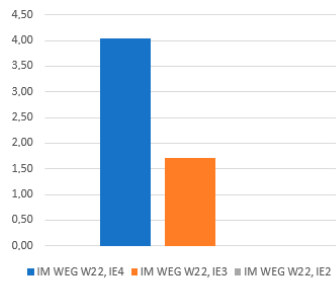
Figure 7. Annual avoided CO 2 emissions ∆ CDE y.3m